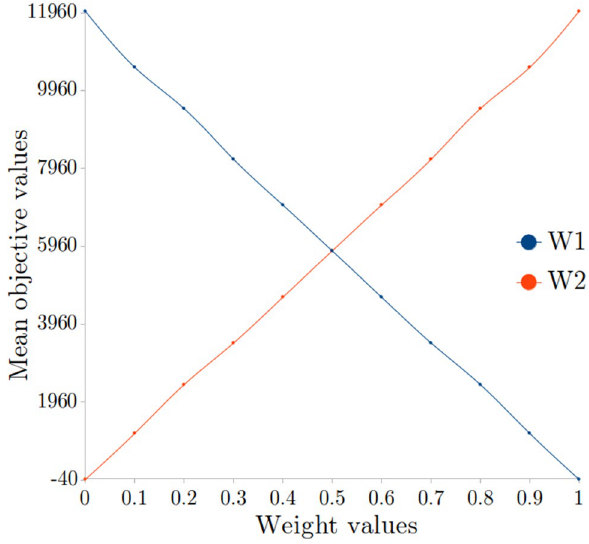
Figure 7. Sensitivity analysis: mean value of the objective function across the three regions vs.